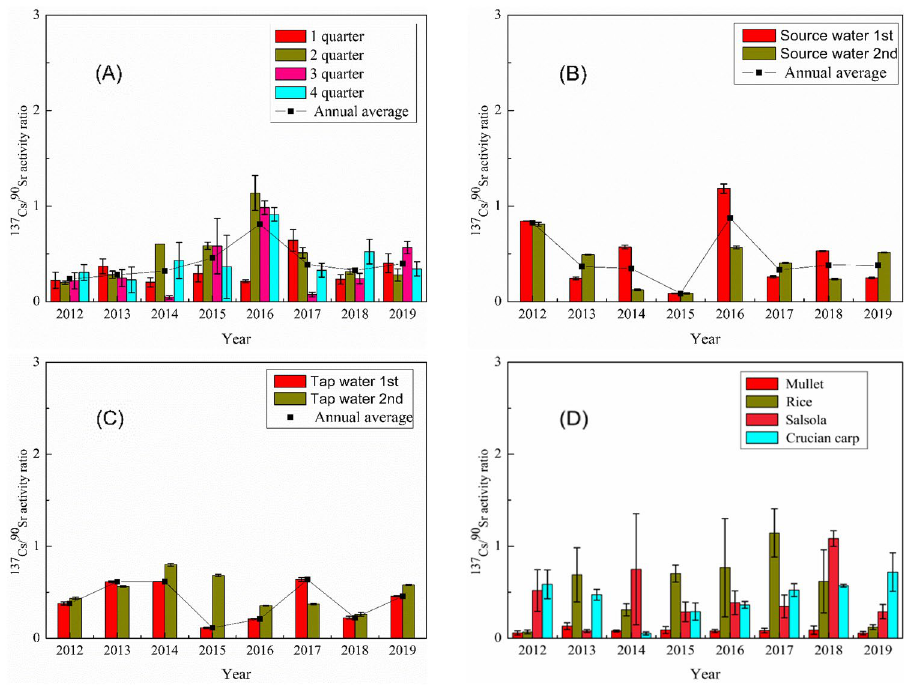
Figure 5. 137 Cs/ 90 Sr activity ratio in total atmospheric deposition ( A ), source water ( B ), tap water ( C ) and food samples ( D ) during